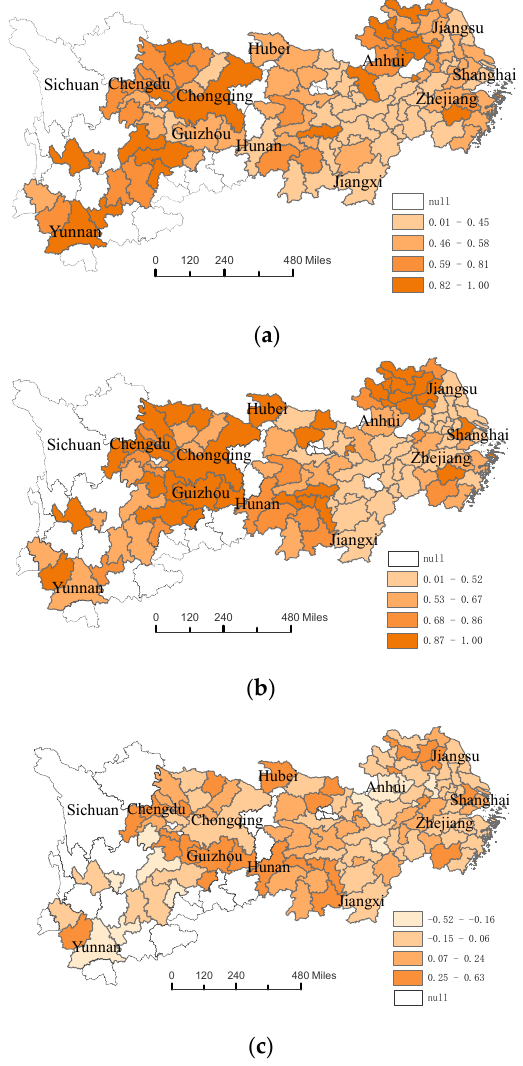
Figure 2. Distribution maps of CLUE in YREB: ( a ) CLUE 2001; ( b ) CLUE 2019; ( c ) CLUE (changes from 2001 to 2019).